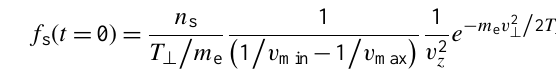
Fig. 2. Electron distribution function for S1 set of parameters at times t = ( 0 ; 7 . 7 × 10 2 ; 9 . 7 × 10 2 ; 1 . 1 × 10 3 ) 1 sured in v T, c